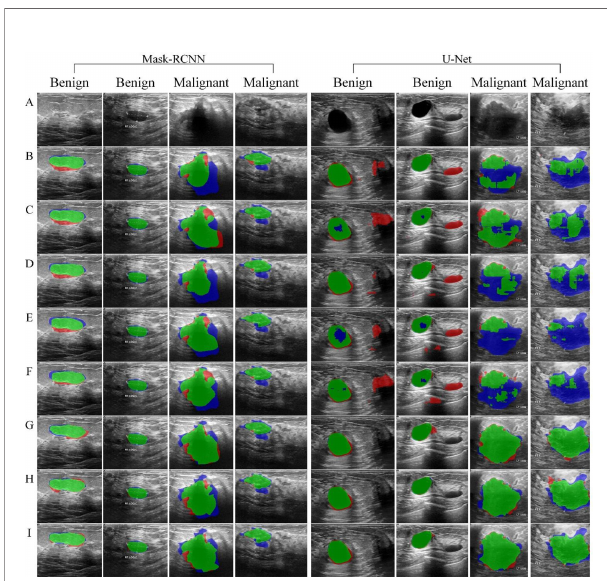
FIGURE 8 | Tumor segmentation results. The blue area refers to the ground truth, the red refers to the prediction result, and the green refers to the overlap area. (A) original image, (B) Baseline, (C) RefMeth_1, (D) RefMeth_2, (E) RefMeth_3, (F) RefMeth_4, (G) PropMeth_1, (H) PropMeth _2, (I) PropMeth _3.